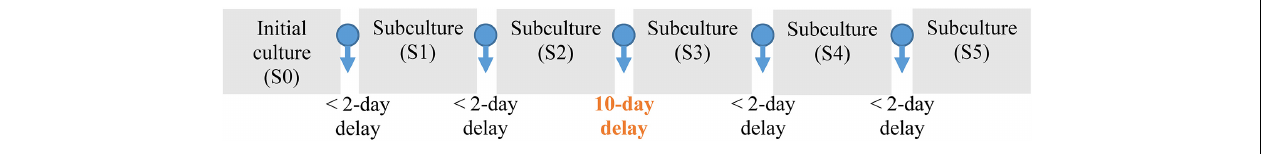
constant ( F = 96485 C mol − 1 ), and the concentration of Fe ( [Fe] in mg L − 1